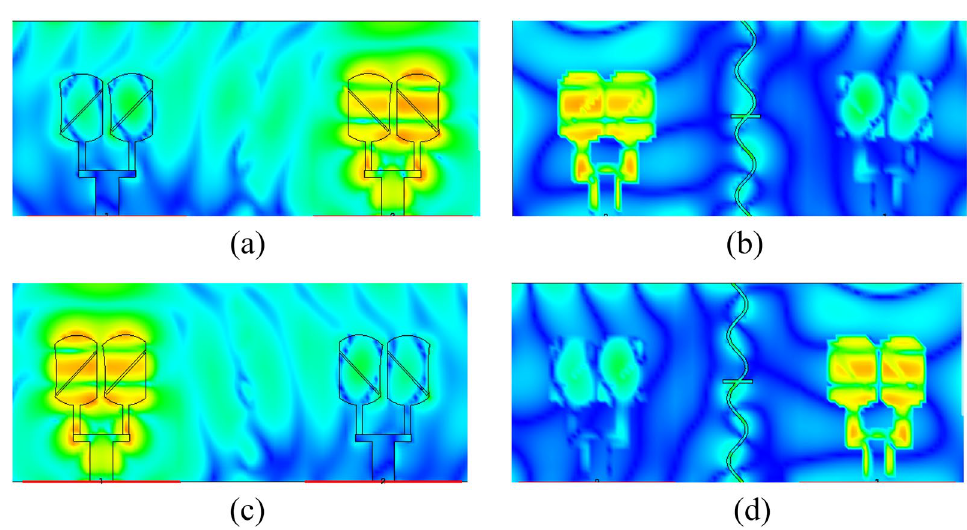
Figure 16. Surface current distribution of proposed MIMO ( a , b ) front and back view of array1 ( c , d ) front and back view of